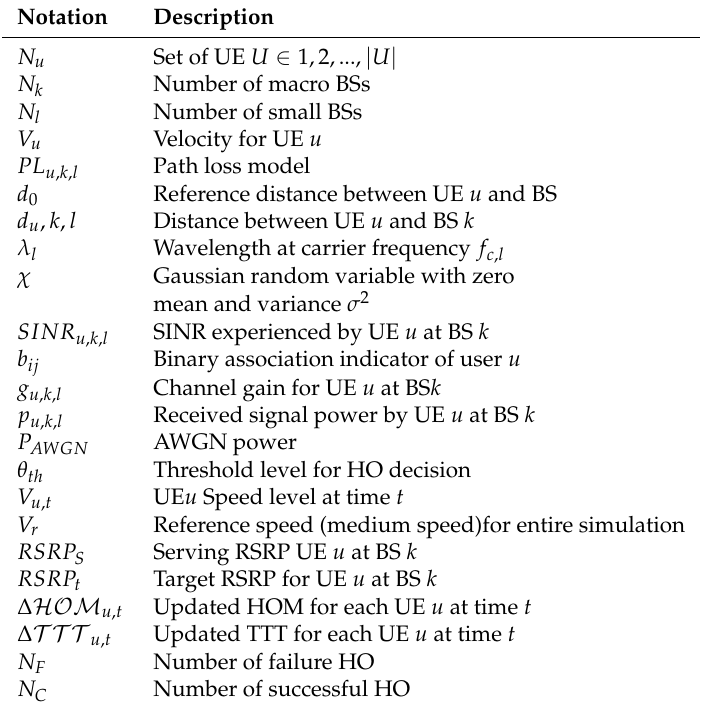
Table 1. List of